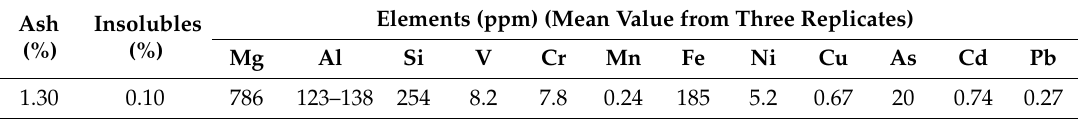
Table A5. Ash, acid insoluble, and inorganic components in the oil drawn from Nakhodka’ s cargo tanks [21]. Ash